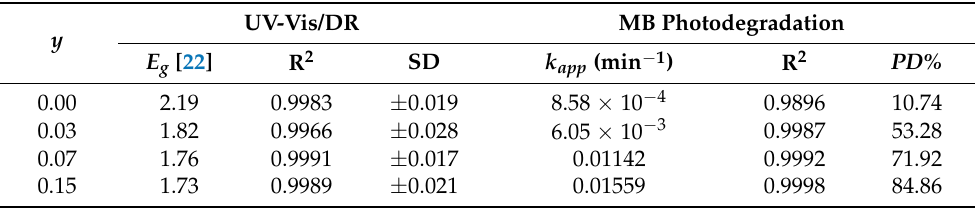
Figure 8. Time ‐ dependence of MB adsorption onto BiFeVOx.y for ( a ) y = 0.03, ( b ) y = 0.07, and ( c ) y = 0.15, in the dark. It is observed that 25 min was sufficient to reach the adsorption equilibrium. The estimated values of equilibrium time [14], bulk MB concentration [15] and the maximum amount of MB adsorbed at equilibrium (q max ) are listed in Table 3 as the mean ± SD derived